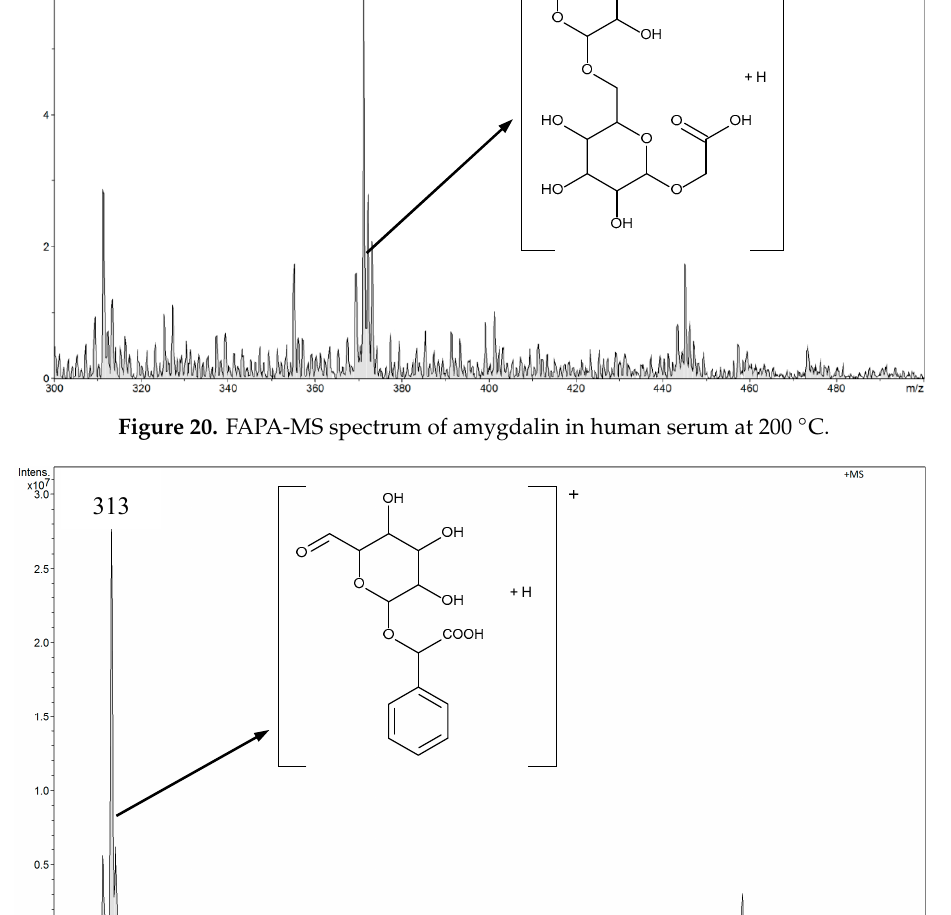
Figure 21. FAPA-MS spectrum of amygdalin in human serum at 340 °C.